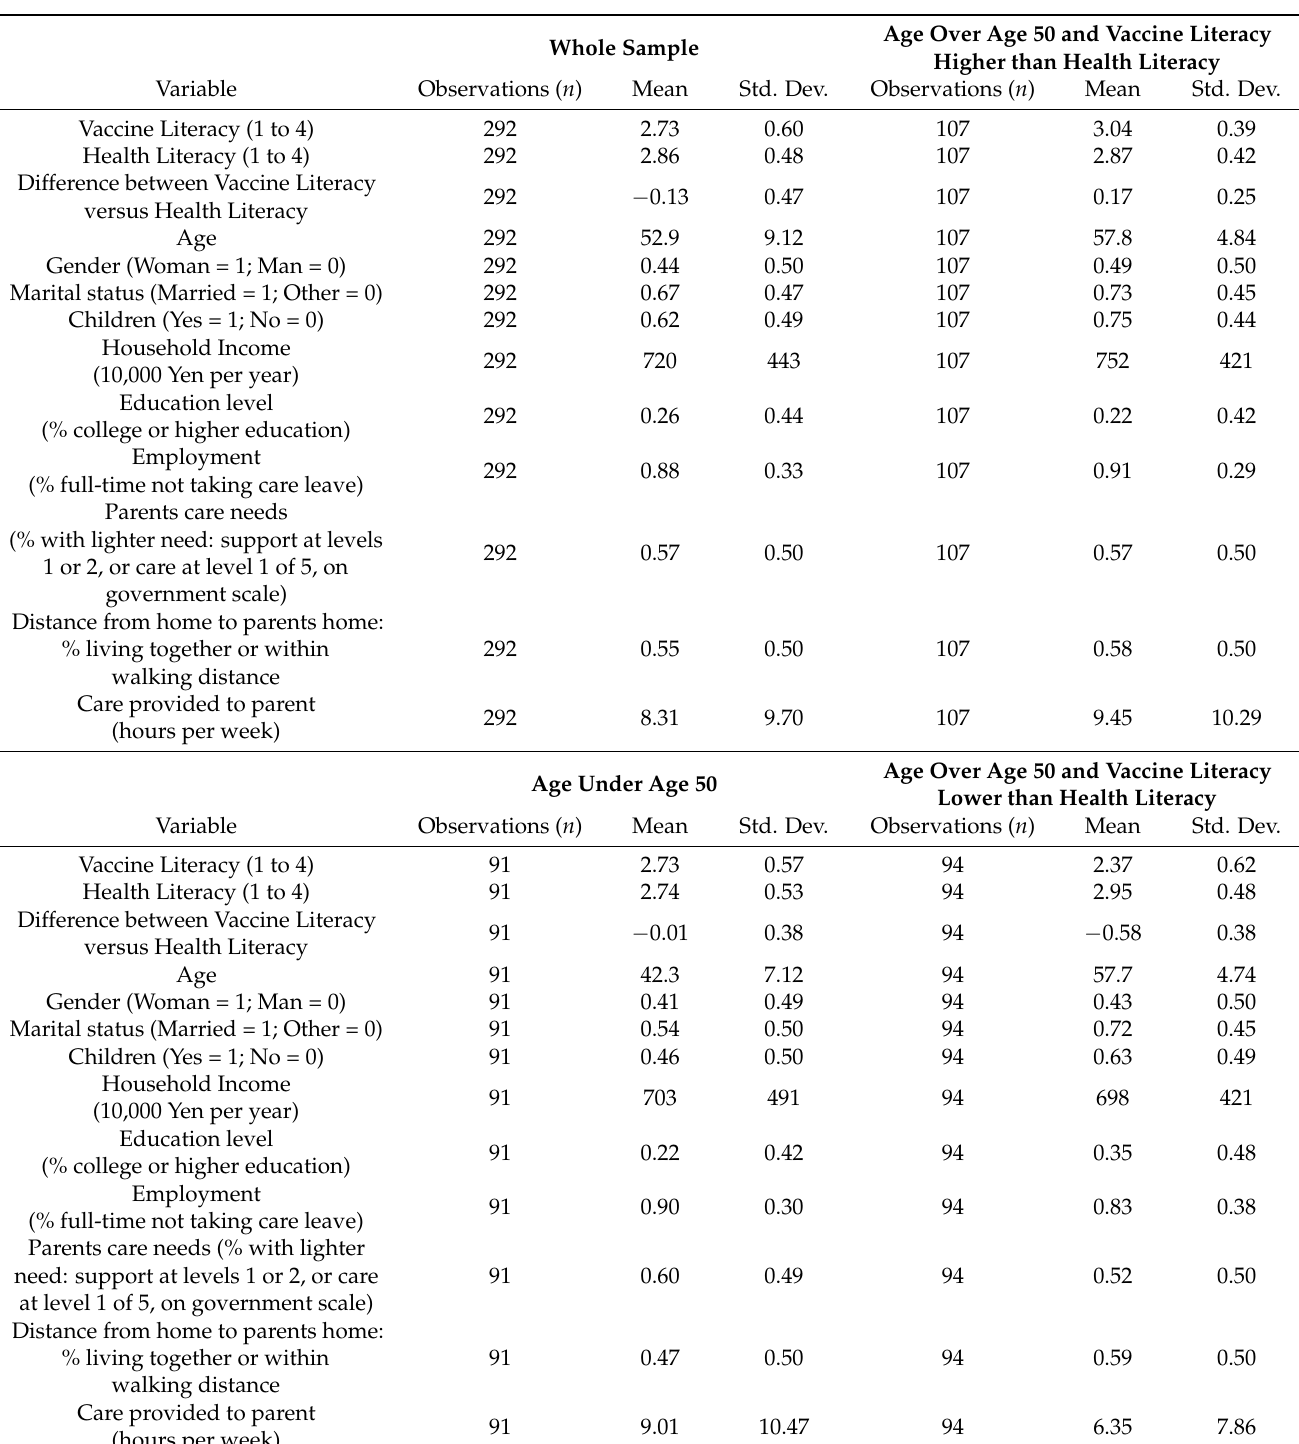
score. Focusing on the two groups over the age of 50, the difference in the means of vaccine literacy is 0.7 ( p < 0.001) and not significant for health literacy. Considering the other variables, the difference between the two groups is almost significant for having children ( p = 0.066) and significant for hours of care provided to parents ( p = 0.018). Table 1. Demographic, work and care characteristics for sub-samples based on age and difference in vaccine literacy versus health literacy. Age Over Age 50 and Vaccine Literacy Whole Sample Higher than Health Literacy Variable Observations ( n ) Mean Std. Dev. Observations ( n ) Mean Std. Dev.